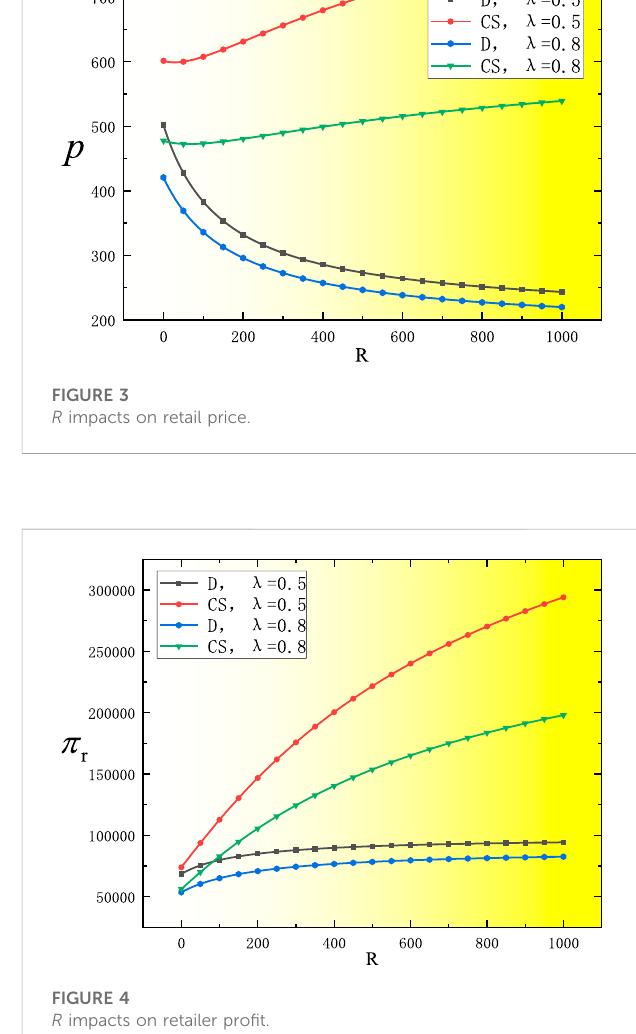
FIGURE 2 R impacts on the greenness of the product.